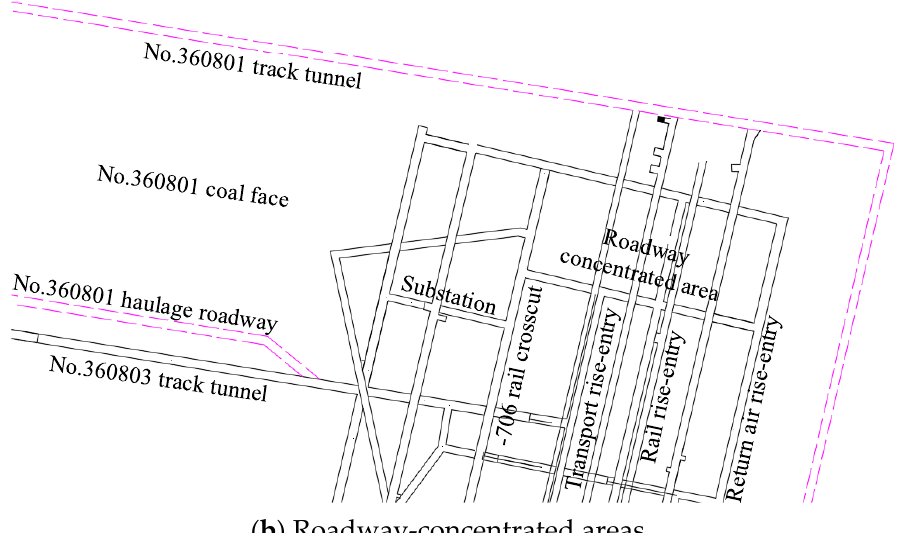
( b ) Roadway-concentrated areas. Figure 2. Layout plan of the No. 360801 coal face and roadway-concentrated areas.